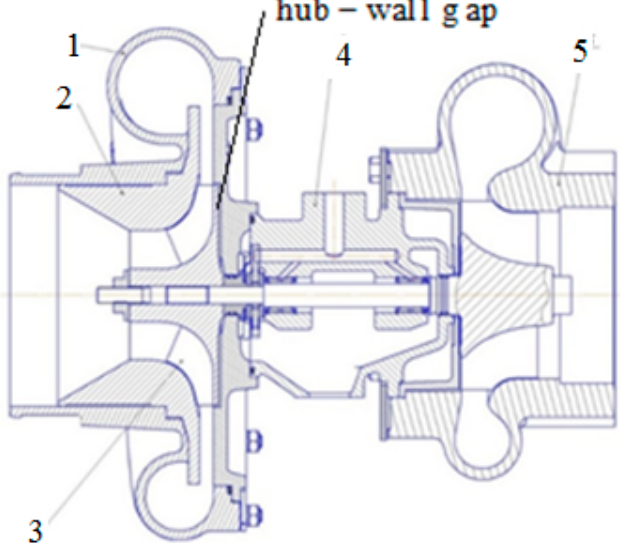
Figure 6. Sectional drawing of the turbocharger TKR 140E. 1—compressor housing; 2—shroud; 3—compressor impeller; 4—bearing housing; 5—turbine.